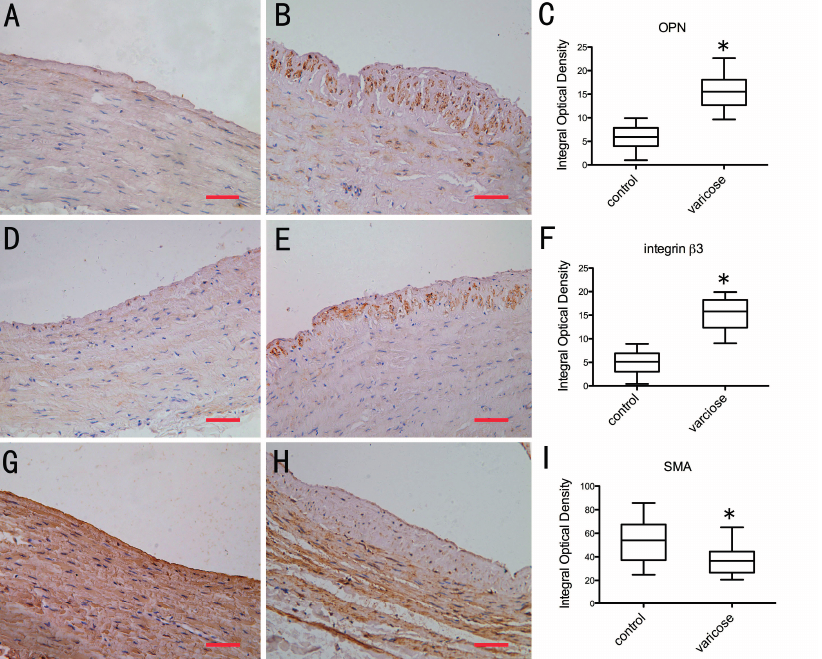
Figure 3. Immunostaining of Osteopontin (OPN), integrin β 3 and Smooth Muscle α -Actin (SMA) in vein specimens. ( A ) immunostaining of OPN in normal vein; ( B ) immunostaining of OPN in varicose vein; ( D ) immunostaining of integrin β 3 in normal vein; ( E ) immunostaining of integrin β 3 in varicose vein; ( G ) immunostaining of SMA in normal vein; ( H ) immunostaining of SMA in varicose vein; ( C , F , I ) Quantitative analysis of the difference of OPN, integrin β 3 and SMA expression in normal vein and varicose vein. Data are presented as medians and inter-quartile ranges ( * p < 0.0001 vs. Normal veins). Scale bar = 50 μ m.